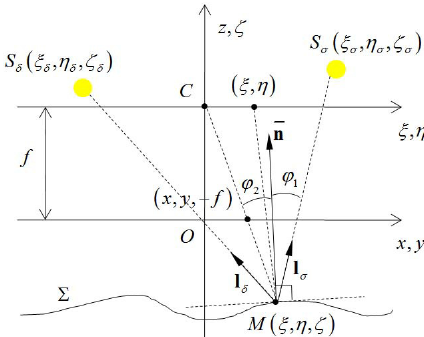
Figure 6. Lambertian reflection and specular reflection under illumination from different light sources. The light source S δ creates Lambertian reflection, while the light source S σ creates specular